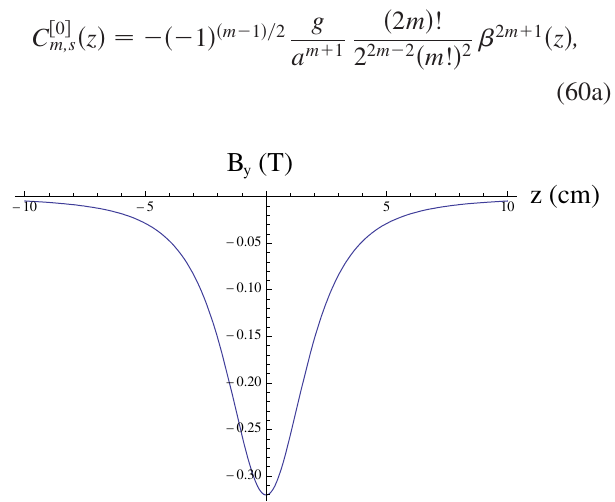
ð x ¼ 0 ; y ¼ 0 ; z Þ y